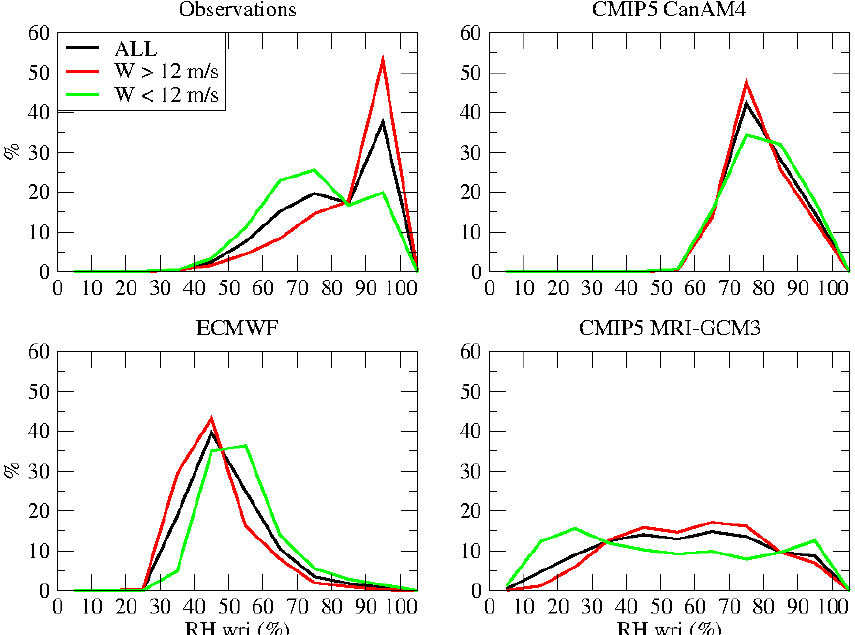
Figure 6. Frequency distribution of RH wri values, for 10m wind speed above (red) or below (green) 12ms − 1 , or all cases (black), in the D17observations, the ECMWF operational analyses, and simulations by two general circulation models from the CMIP5 archive, CanAM4 and MRI-GCM3. The simulations are of the AMIP (Atmospheric Model Intercomparison Project) type; that is, the atmospheric component of the climate models is used with prescribed observed monthly sea-surface boundary conditions, but turbulent fluxes on continental surfaces are simulated. Results are shown for two models in the archive for which the 3-hourly AMIP results for both surface wind and for RH wri are